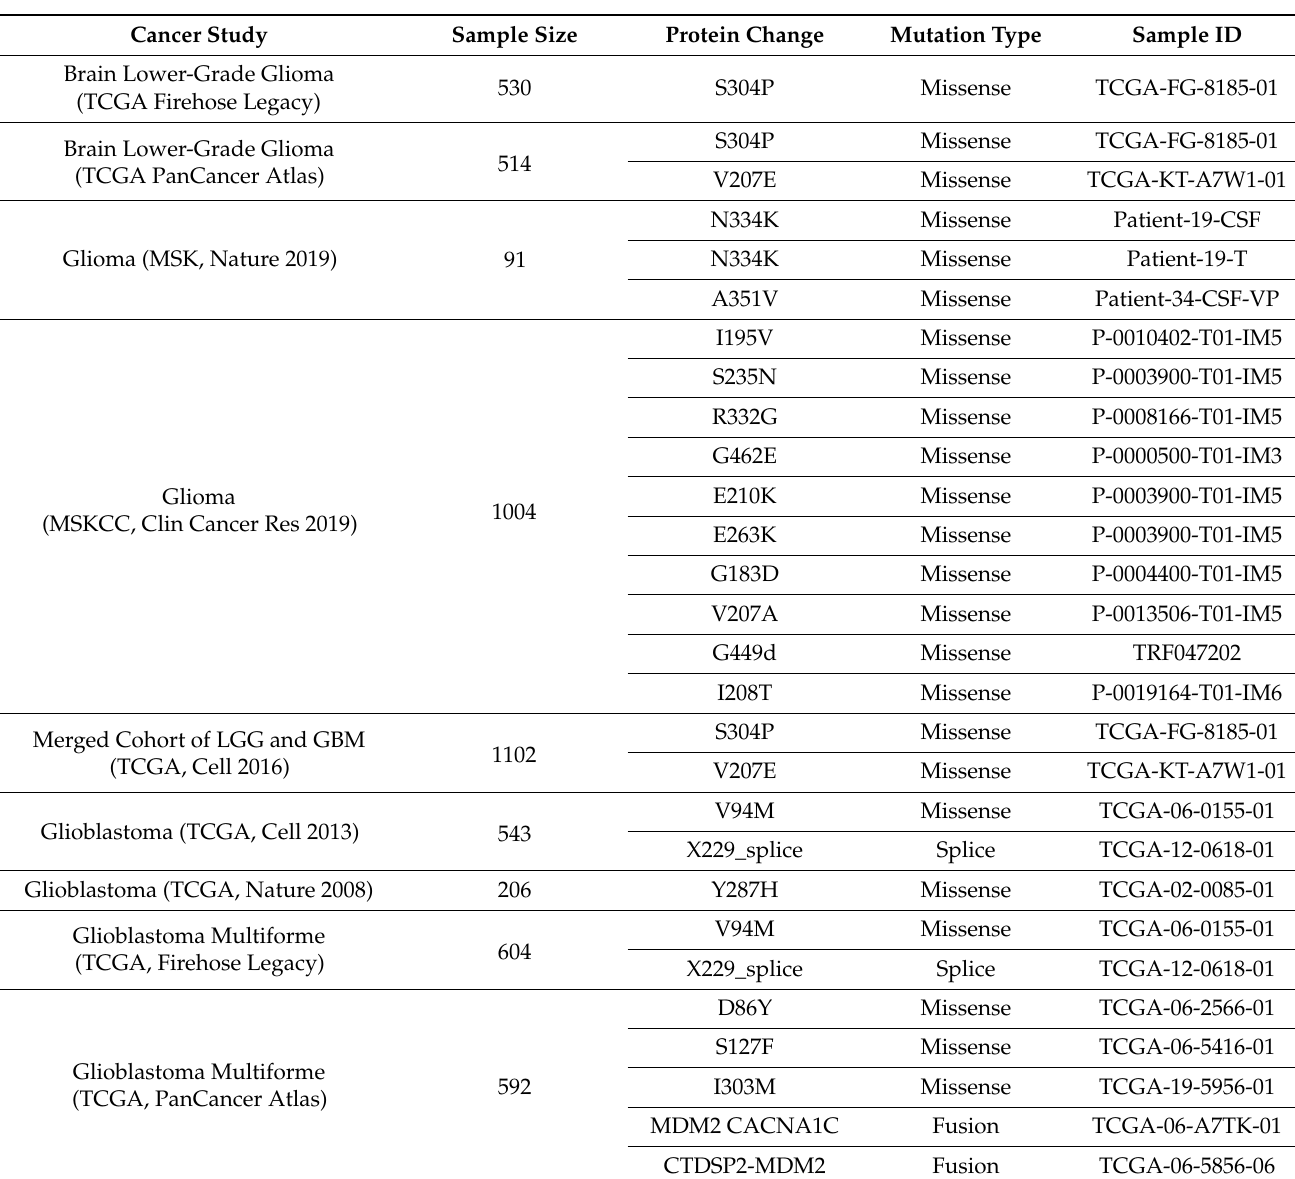
Table 1. Inheritance changes in MDM2 gene configurations linked to brain cancer growth progres- sion in lower-grade gliomas (LGGs) are described. In total, 28 mutations were found, 6 of which were